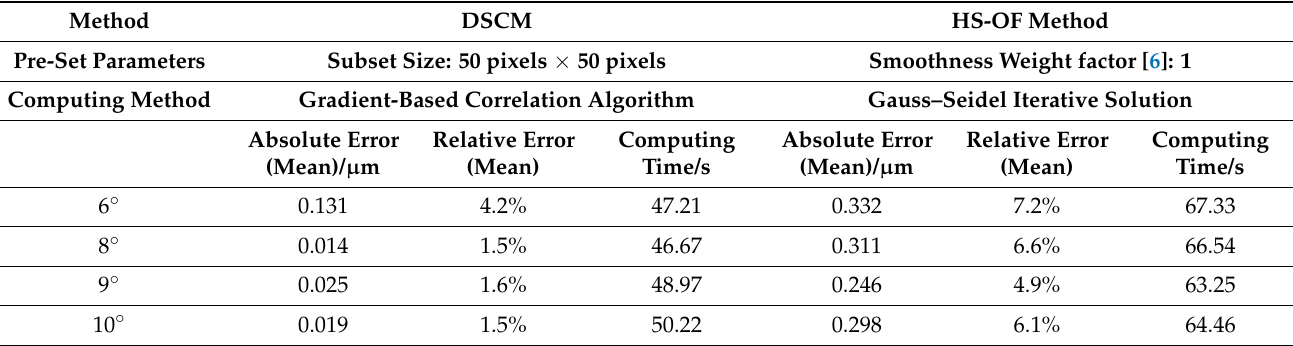
Figure 7. Comparison cross-section data in the y direction at x = 174. Table 1. Main parameters comparison of DSCM and OF method based on the data in Figure 7.